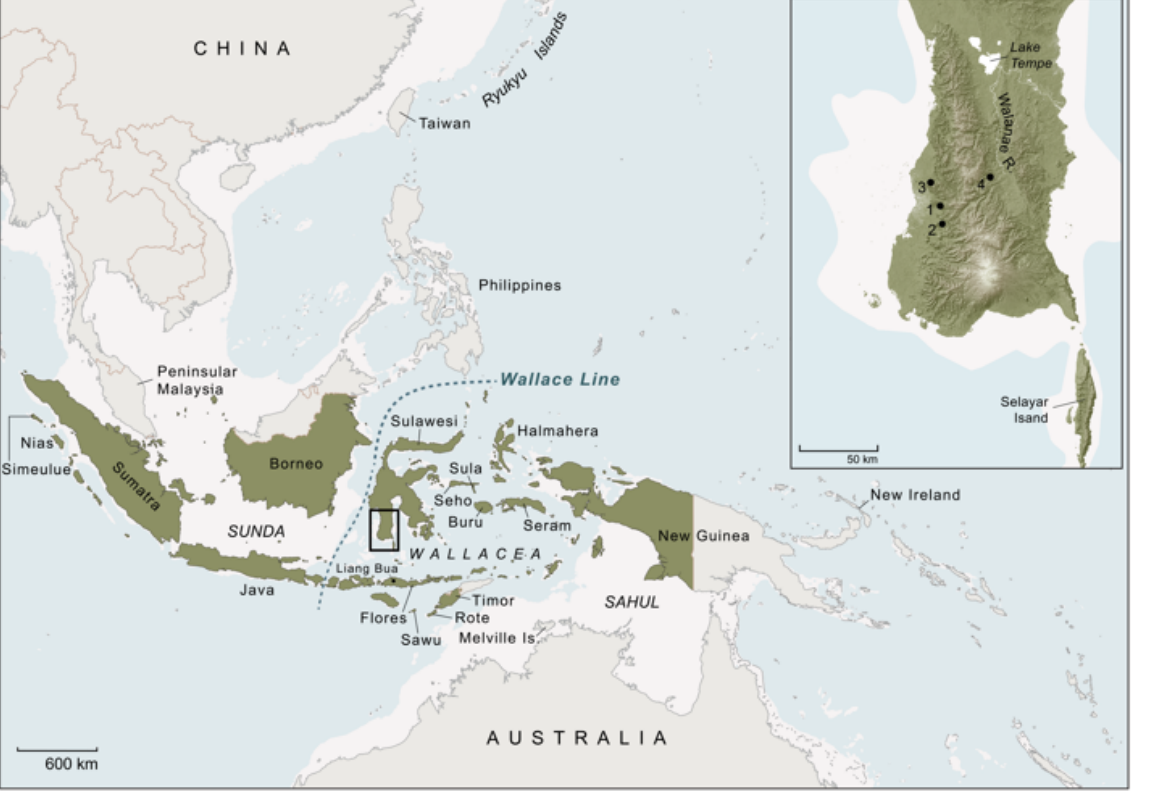
Figure 2. Island Southeast Asia and the wider region. Islands and provinces of the Republic of In- donesia are shaded green. White shading represents land areas exposed during Late Pleistocene low sea level stands. The Wallacean archipelago (Wallacea) is located east of the Wallace Line, the bio ‐